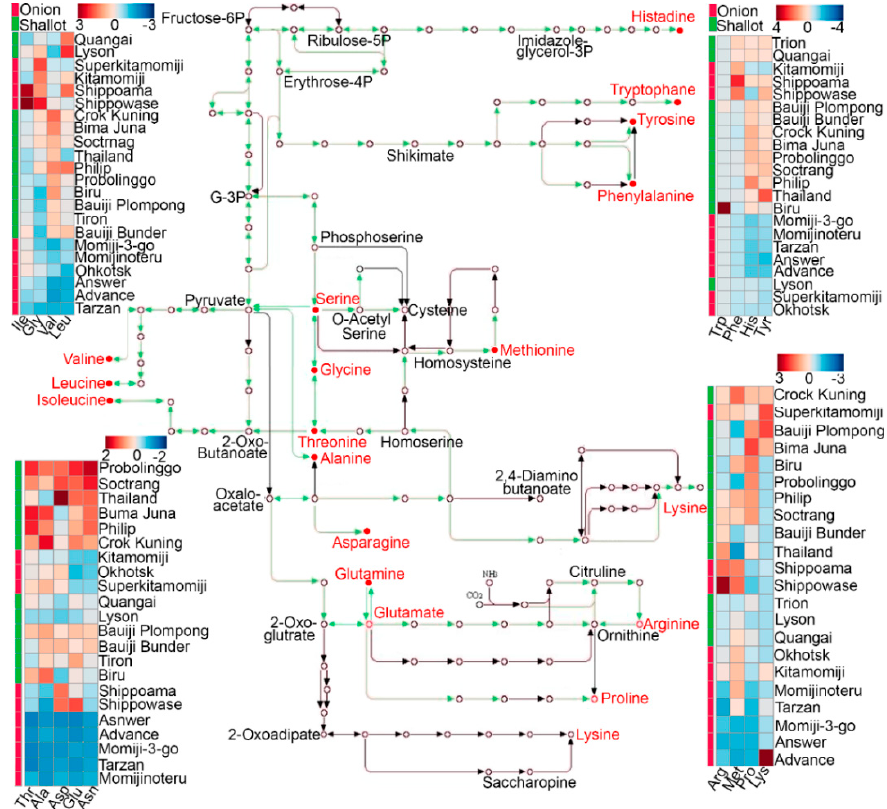
Figure 4. Amino acid profiles of bulb onion cultivars and shallot landraces measured using an amino acid analyzer. The amino acid profiles in the investigated genotypes were mapped onto the amino acid biosynthesis pathway derived from the Kyoto Encyclopedia of Genes and Genomes (KEGG) database.